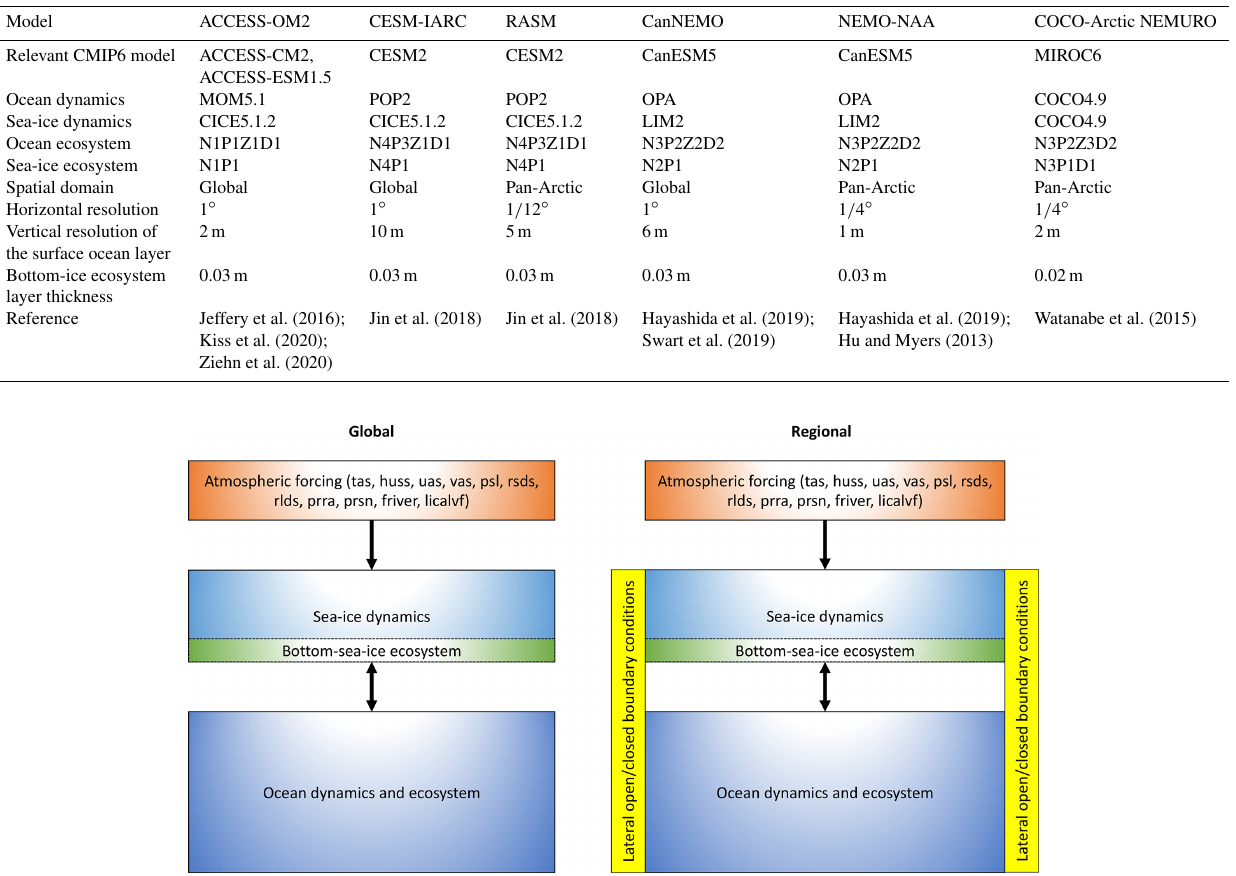
Table 1. List of participating models for IAMIP2. For ocean and sea-ice ecosystem components, the letters denote nutrients (N), phytoplank- ton (P), zooplankton (Z), and detritus (D), which are followed by the numbers indicating the complexity. For example, N1 denotes one type of modelled nutrients (e.g., nitrate), whereas N2 indicates two types of modelled nutrients (e.g., nitrate and iron). The vertical resolution is rounded to the nearest integer.